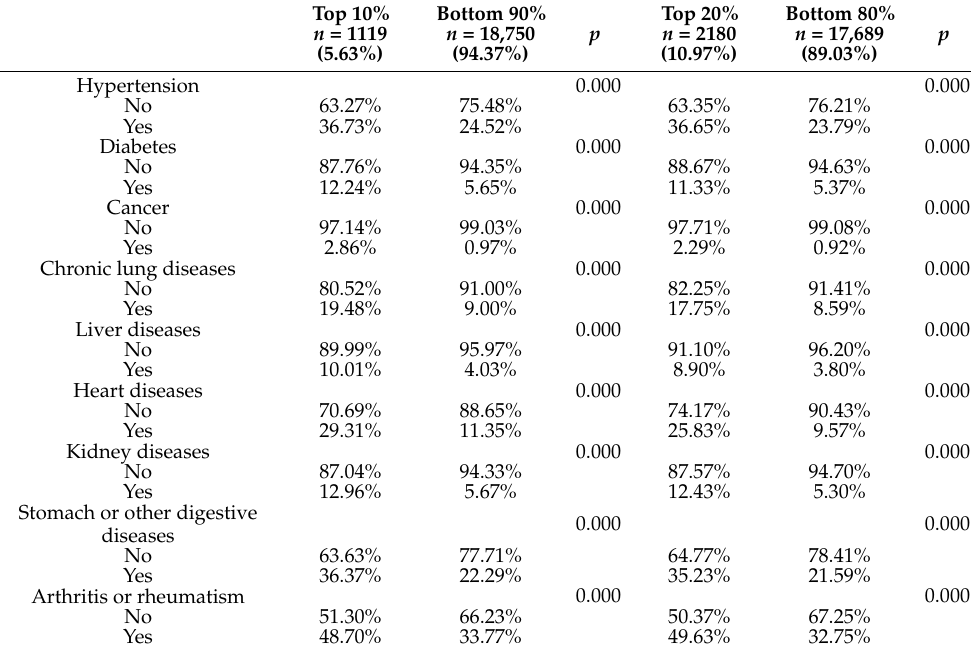
Table 3. Chronic diseases in middle-aged and elderly participants with the top 10% and 20% of medical expenses.